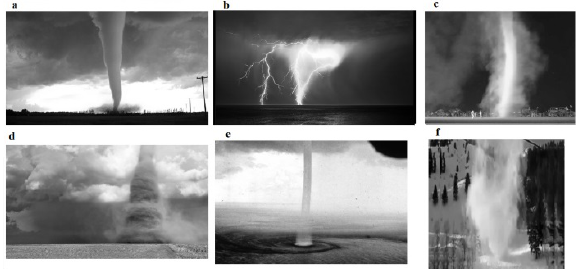
Fig. 6. CSACE generators the formation of a tornado. The figure shows: a - atmospheric tornado; b-lightning tornado; c - fire tornado; d-dusty "devil"; e-water tornado; f-snow tornado.